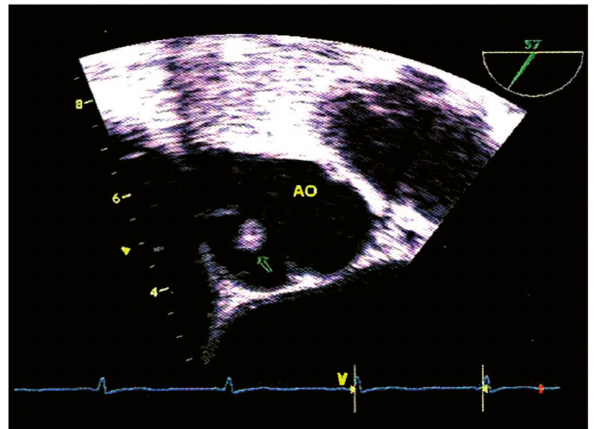
Fig. 1 – Transesophageal echocardiography showing a rounded echodense mass with 7 mm attached to the non-coronary cusp of the aortic